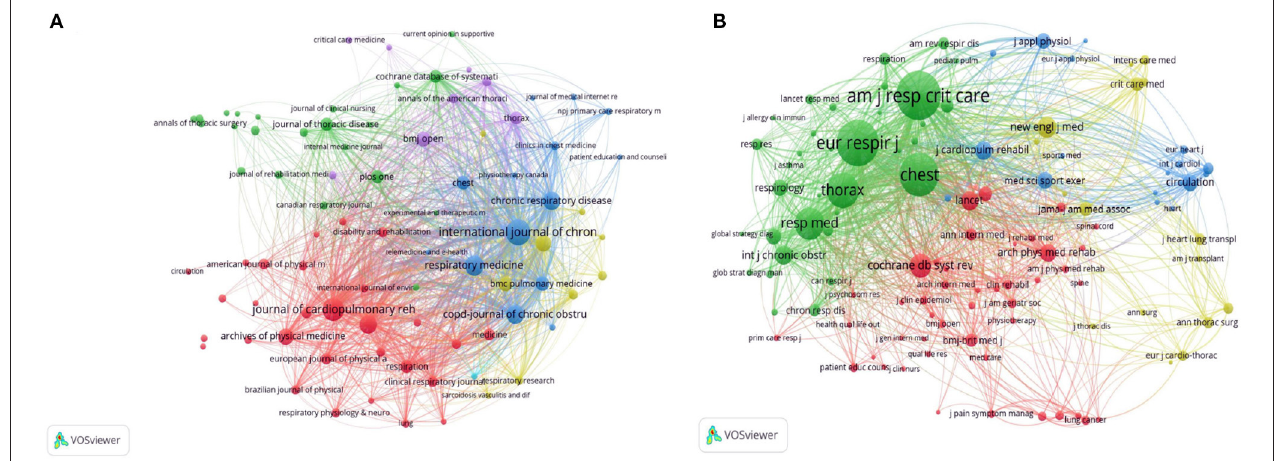
FIGURE 6 | (A) The network map of academic journals [ (A) , T ≥ 10]. (B) The network map of co-cited journals [ (B) , T ≥ 200] for research on pulmonary